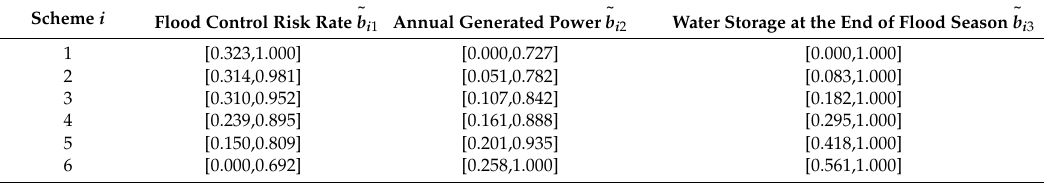
Table 5. Standardized interval number decision matrix (cid:101) B .